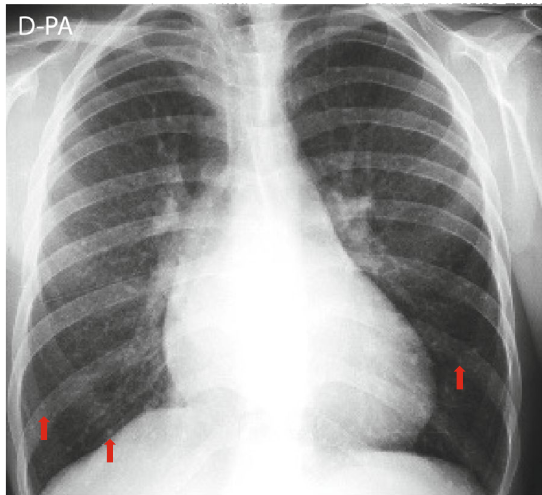
Fig. 1 Chest radiograph showing bilateral micronodular infiltrate (red arrows)